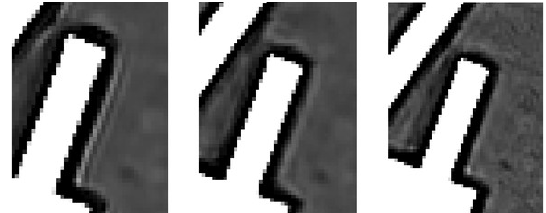
Figure 9 Loss function ablation results on real images. Left L1 Loss Centre: L1 + MS-SSIM Right: L1+DISTS. L1+DISTS appear sharper and with less artifacts and ringing